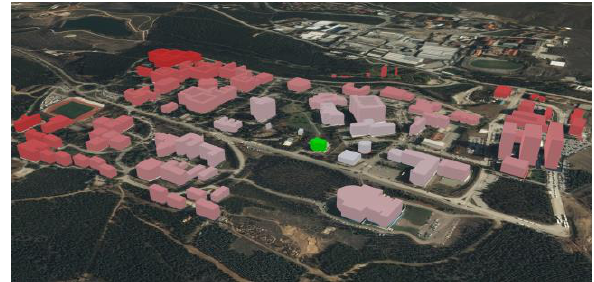
Figure 6. Buildings colored by distance to a landmark (Geomatics Engineering Department building depicted with green) on Cesium.